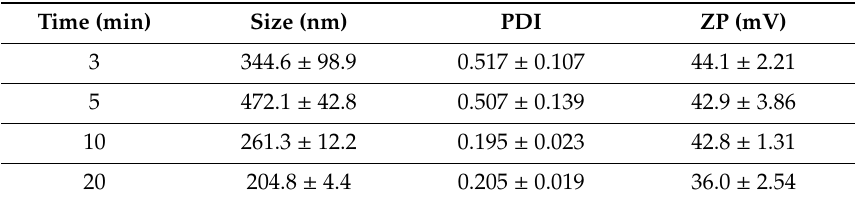
Table 1. Effects of sonication time on size, polydispersity index (PDI), and zeta potential (ZP) of blank chitosan nanoparticles (CSNPs).